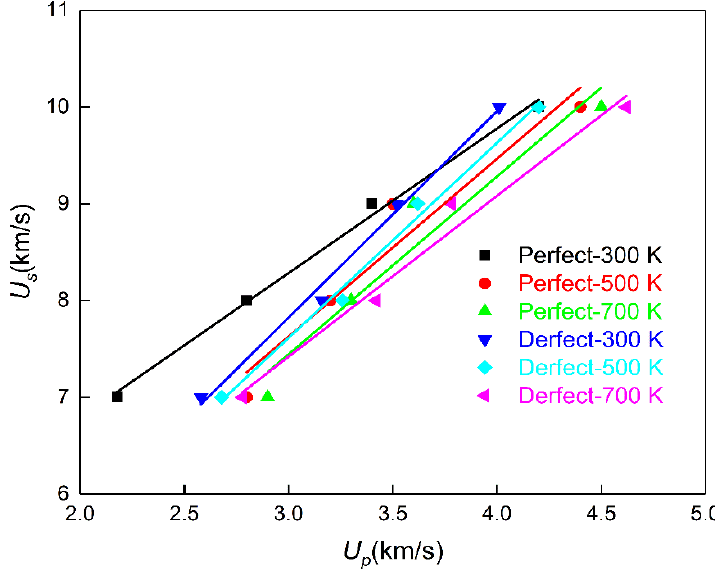
Figure 3. Shock wave velocity versus particle velocity.